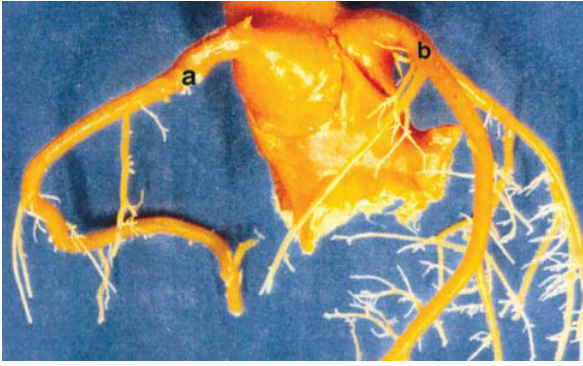
Fig. 1 - Origem das artérias coronárias - a: artéria coronária